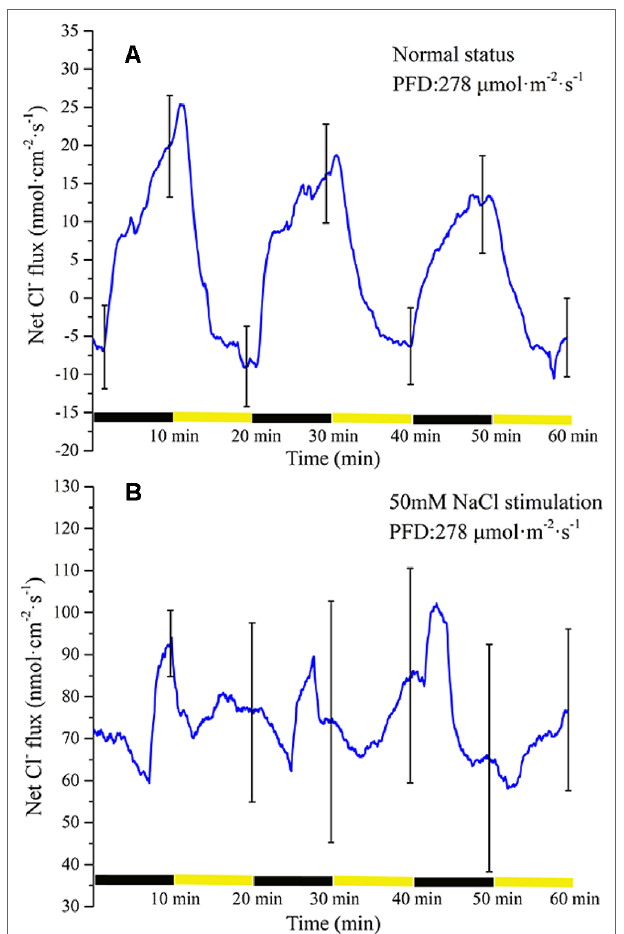
FIgURe 8 | Measurement of net Cl − flux before and after 50 mM NaCl stimulation. (a) Net Cl − flux induced by periodic illumination/darkness without NaCl stimulation (normal condition). (B) Net Cl − flux induced by periodic illumination/darkness with 50 mM NaCl. Negative values represent ion efflux. Note: wavelet decomposition was applied to the raw Cl − flux data to remove noise using the Daubechies (db4) wavelet transform, where wavelet layer number was 1–4. Mean ± SE ( n = 3); n—number of